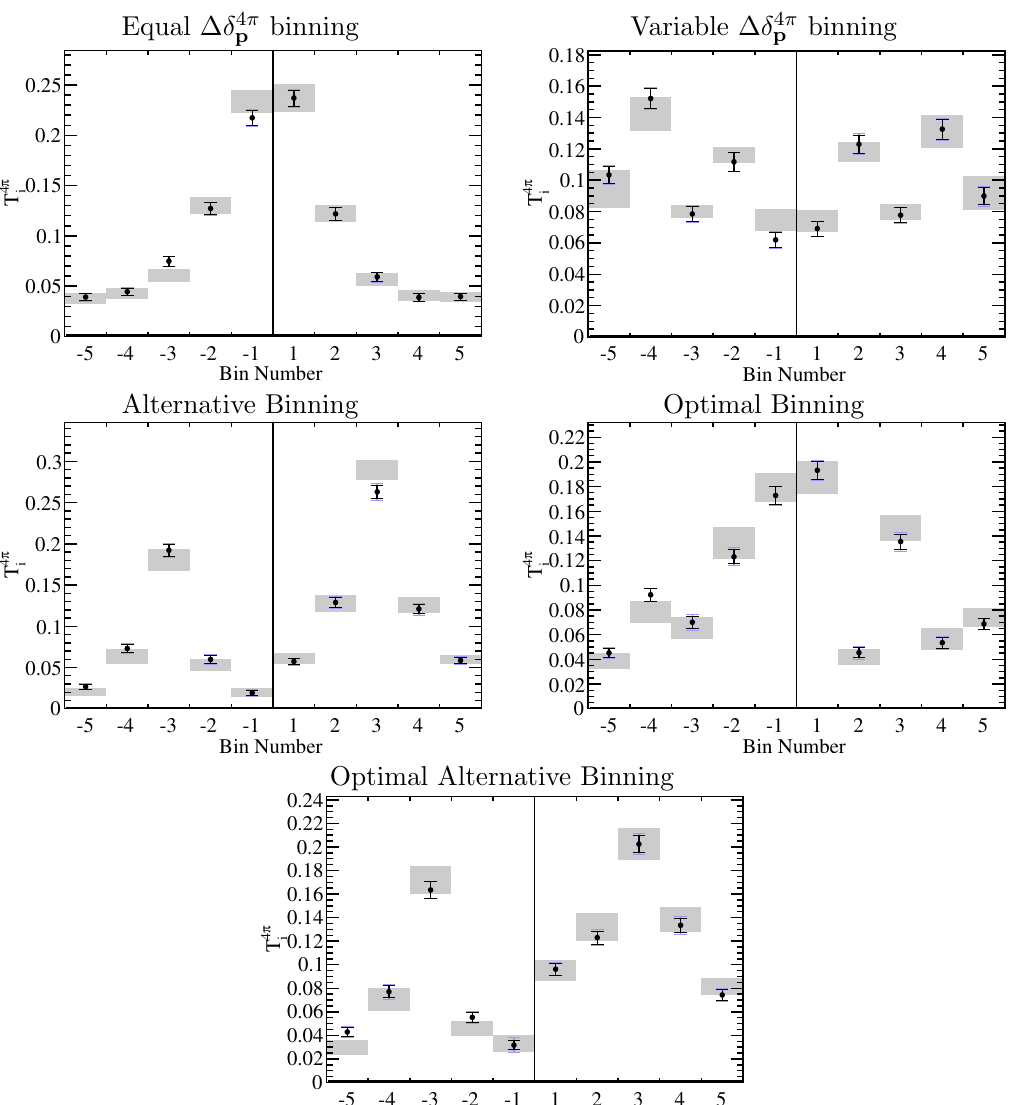
Figure 9 . Each (cid:12)gure shows the hadronic parameters T 4 (cid:25) binning schemes discussed in section 4 where N = 5. The grey bands give the model predictions and uncertainties discussed in section 4. The black (blue) points with errors give the measured values and statistical (statistical + systematic)